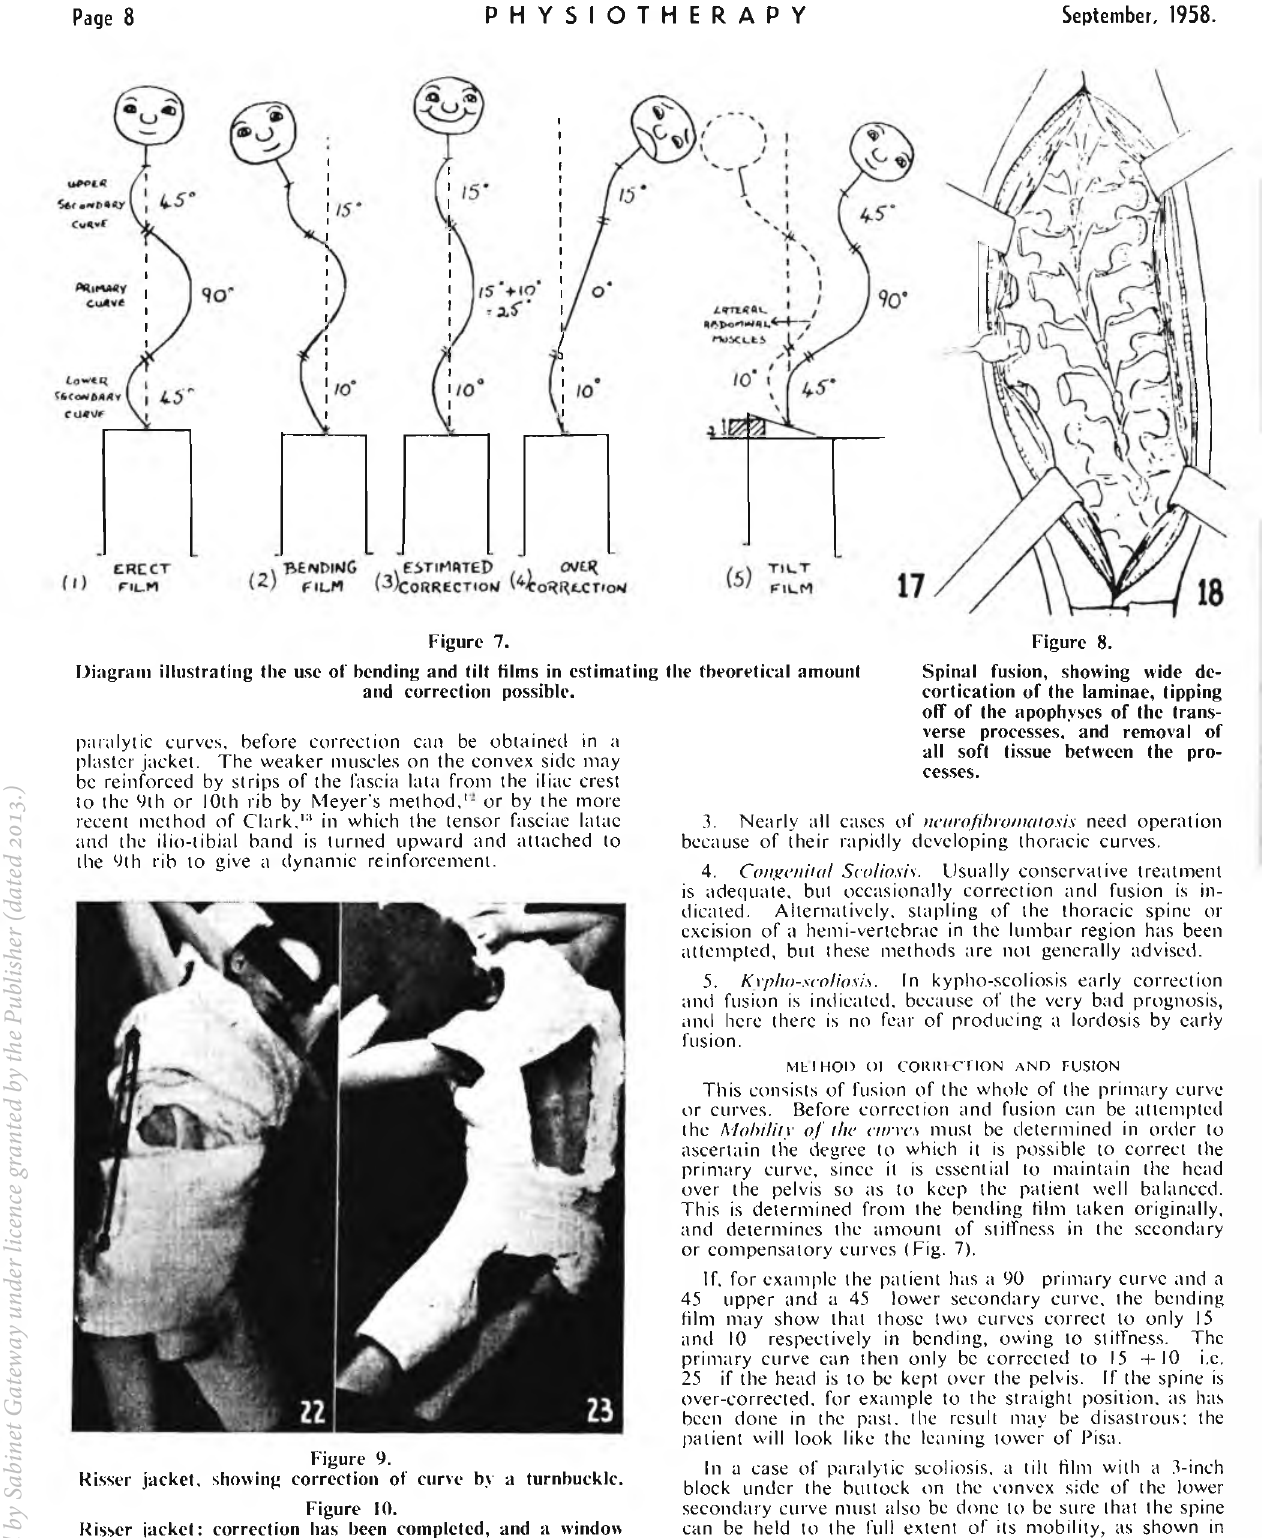
Figure 9. Risser jacket, showing correction of curve by a turnbucklc. Figure 10. Kisser jacket: correction has been completed, and a window cut over spine for